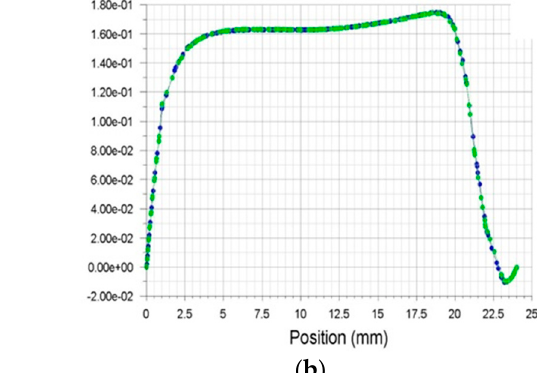
Figure 5. Streamwise x velocity profiles at two downstream stations from the stenosis ( a ) 0.5D, ( b ) 8.0D.